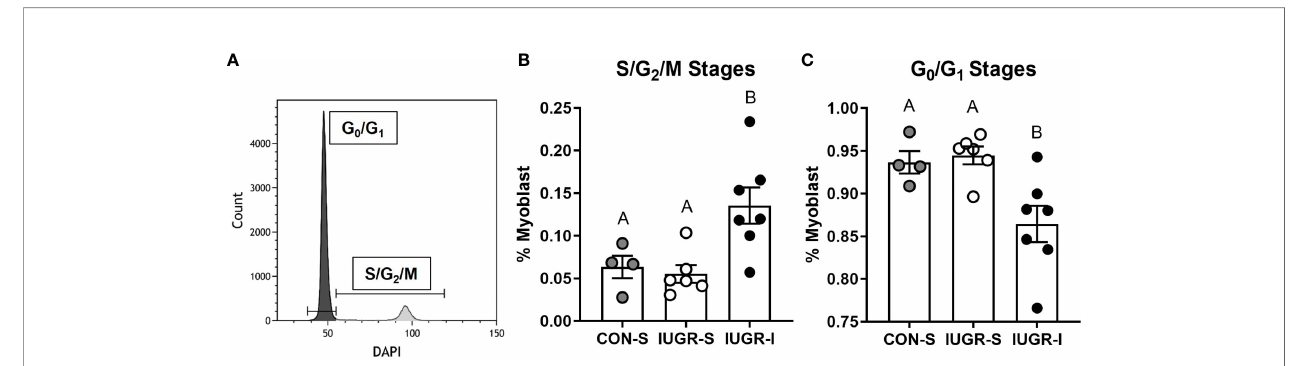
FIGURE 5 | Flow cytometry analysis of cell cycle stages on fetal myoblasts. Fetal myoblasts dissociated from BF muscle were identi fi ed by CD56 marker, then stained with DAPI to identify the cell cycle stage of the myoblasts. (A) Representative plot to identify cell cycle stages of myoblasts using DAPI staining. (B) Myoblasts in the S/G 2 /M stages were 113% and 145% higher in IUGR-I vs . CON-S and IUGR-S, respectively. (C) Myoblasts in the G 0 /G 1 stages were 7.7% and 8.5% lower in IUGR-I vs . CON-S and IUGR-S, respectively. CON-S (grey circle, n=4), IUGR-S (white circle, n=6), and IUGR-I (black circle, n=7). Statistical signi fi cance was designated by different alphabetical letters at P ≤ 0.05 by one-way ANOVA and Fisher ’ s least signi fi cant difference post hoc